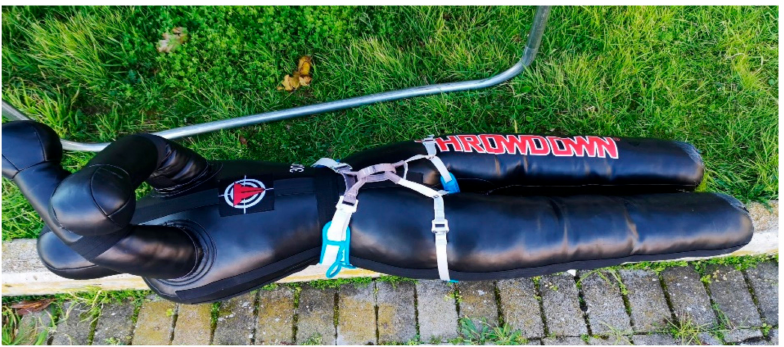
Figure 3. Human shaped